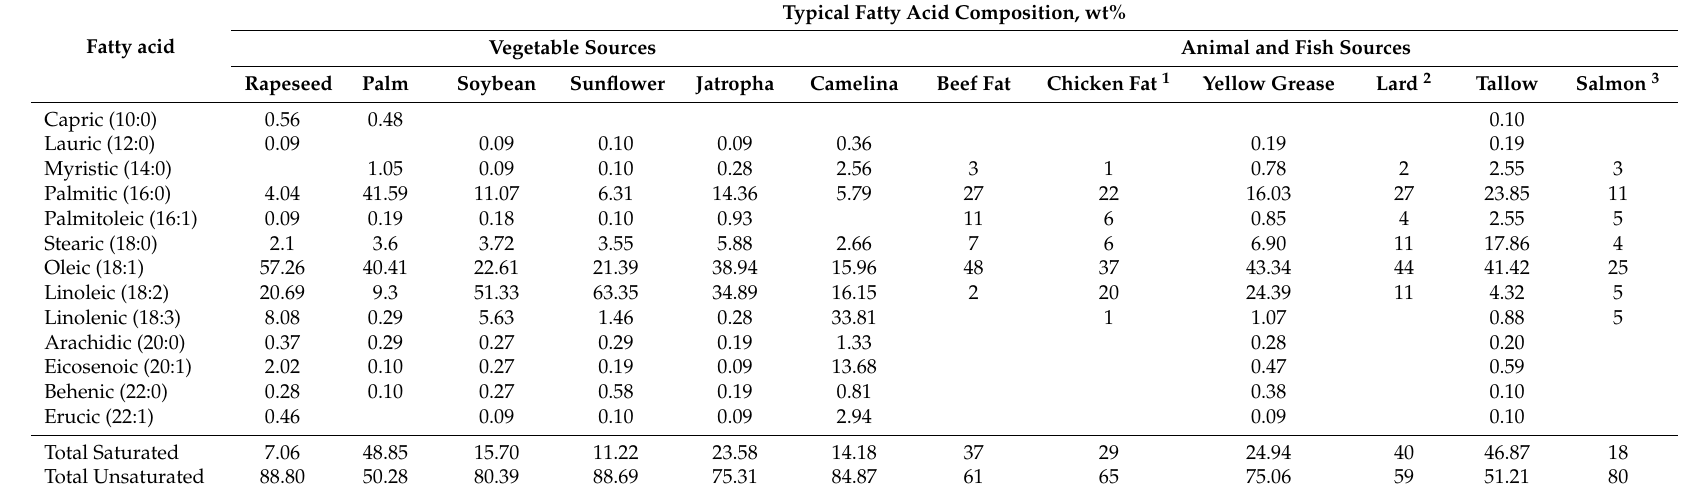
Table 2. Typical fatty acid composition of various vegetable oils, animal fats and fish fats. Data obtained from